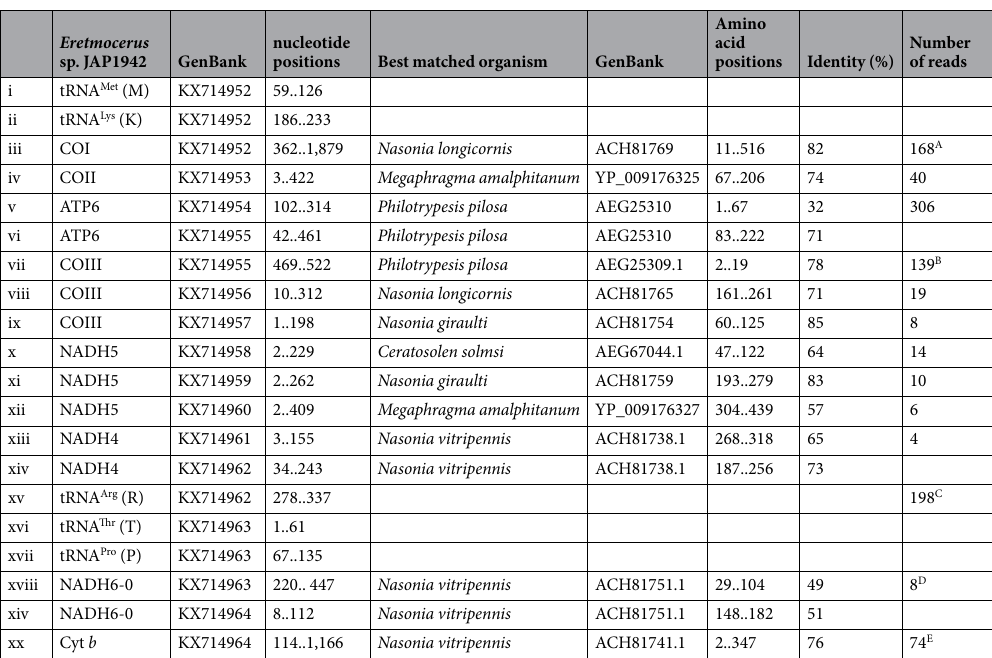
Table 2. Annotations of the detected mitochondrial DNA (mtDNA) genes of a parasitoid Eretmorcerus sp. from the gDNA of the ‘1942’ Japanese Bemisia specimen. A total of 13 DNA fragments (GenBank accession numbers KX714952–KX714964) representing eight mtDNA protein coding genes and five tRNAs were detected. Amino acid positions of the best matched hymenopteran species within the Chalcidoidea superfamily and the percentage identity are also shown. Note : (A) A total of 168 reads for the assembly of (i, ii, iii). (B) A total of 139 reads for the assembly of (vi, vii). (C) A total of 198 reads for the assembly of (xiv, xv). (D) A total of 8 reads for the assembly of (xv, xvi, xvii). (E) A total of 74 reads for the assembly of (xiv,